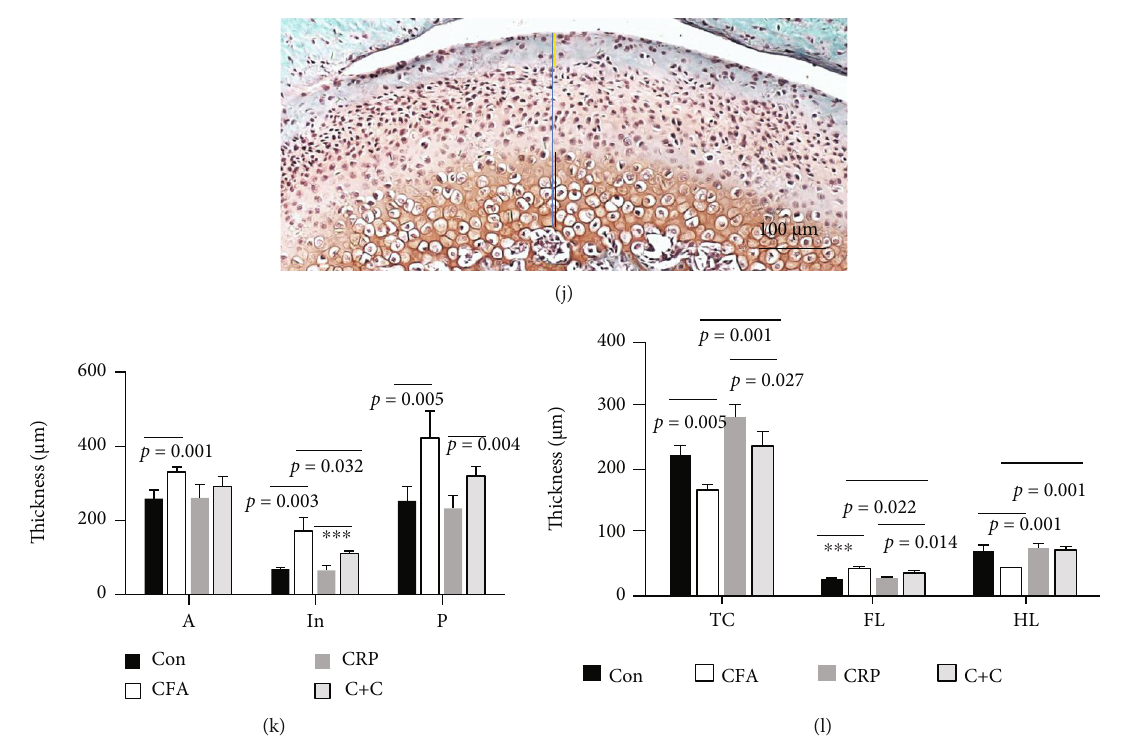
Figure 4: Histological changes in the TMJ disc and cartilage. (a) – (d) Representative images of H&E-stained slides show the middle part of the TMJ disc and cartilage from Con, CFA, CRP, and C + C groups, respectively. (e) – (h) Representative images of safranin O- and fast green-stained slides involving TMJ discs and cartilage from Con, CFA, CRP, and C + C groups, respectively. (i) Photomicrograph showing the disc thickness measurement method (A: anterior band; In: intermediate zone; P: posterior band). (j) Photomicrograph of cartilage thickness measurement, with a blue line indicating the total cartilage thickness (TC), a yellow line indicating the fi brocartilage layer thickness (FL), and a black line indicating the hypertrophic chondrocyte layer thickness (HL). (k) Statistical results of disc thickness in every group. (l) Statistical results of cartilage thickness in every group. ( N = 6 ; mean + SD ; ∗∗∗ p < 0 : 001